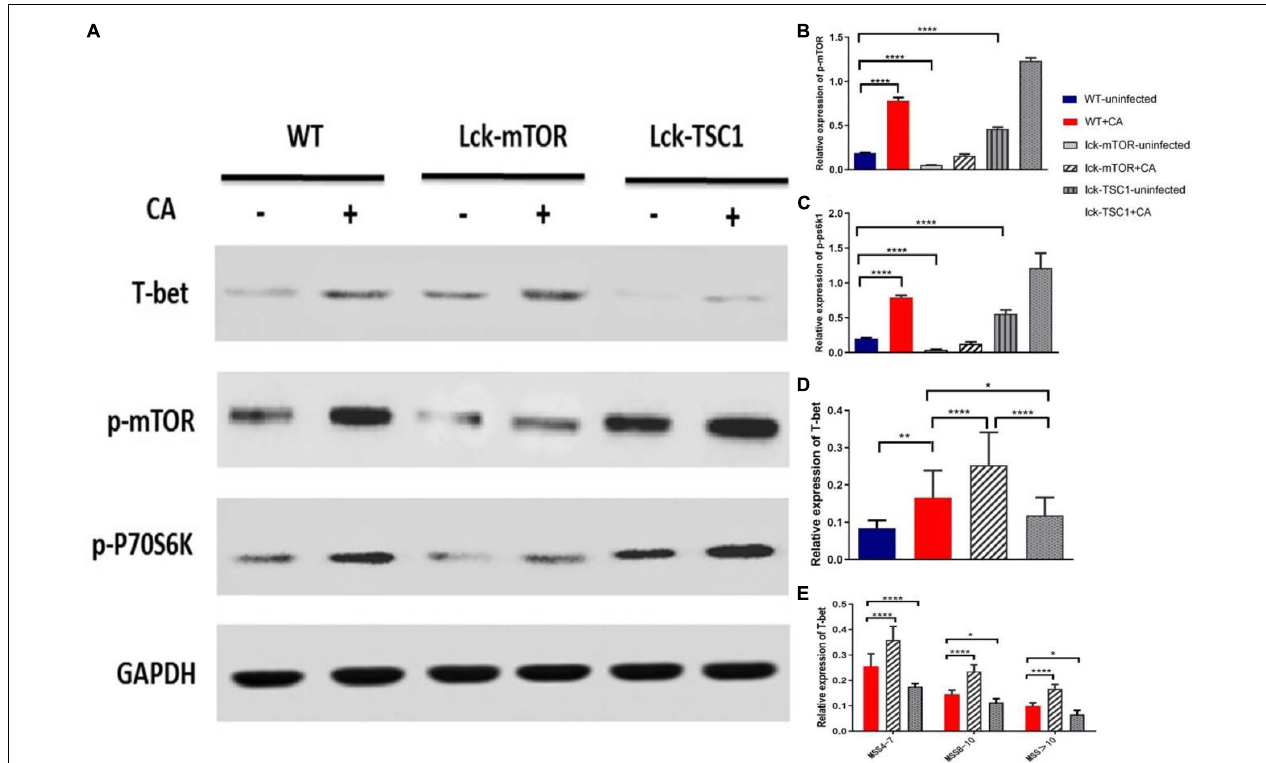
FIGURE 4 | Expression of T-bet in different degrees of Candida sepsis is regulated by mTOR. (A–E) Protein levels of T-bet, phospho (p)-mTOR and p-P70S6 were quantified by western blotting from sorted CD4 + T cells in wild-type (WT), mTOR knockout ( Lck-mTOR ) and TSC1 knockout ( Lck-TSC1 ) mice. The amount of each protein level was normalized by GAPDH. Mean ± SD, 10 mice per MSS group (“+CA” groups contained all infected mice of three MSS groups), analyzed by one-way analysis of variance multiple comparisons. * P < 0.05, ** P < 0.01, **** P <